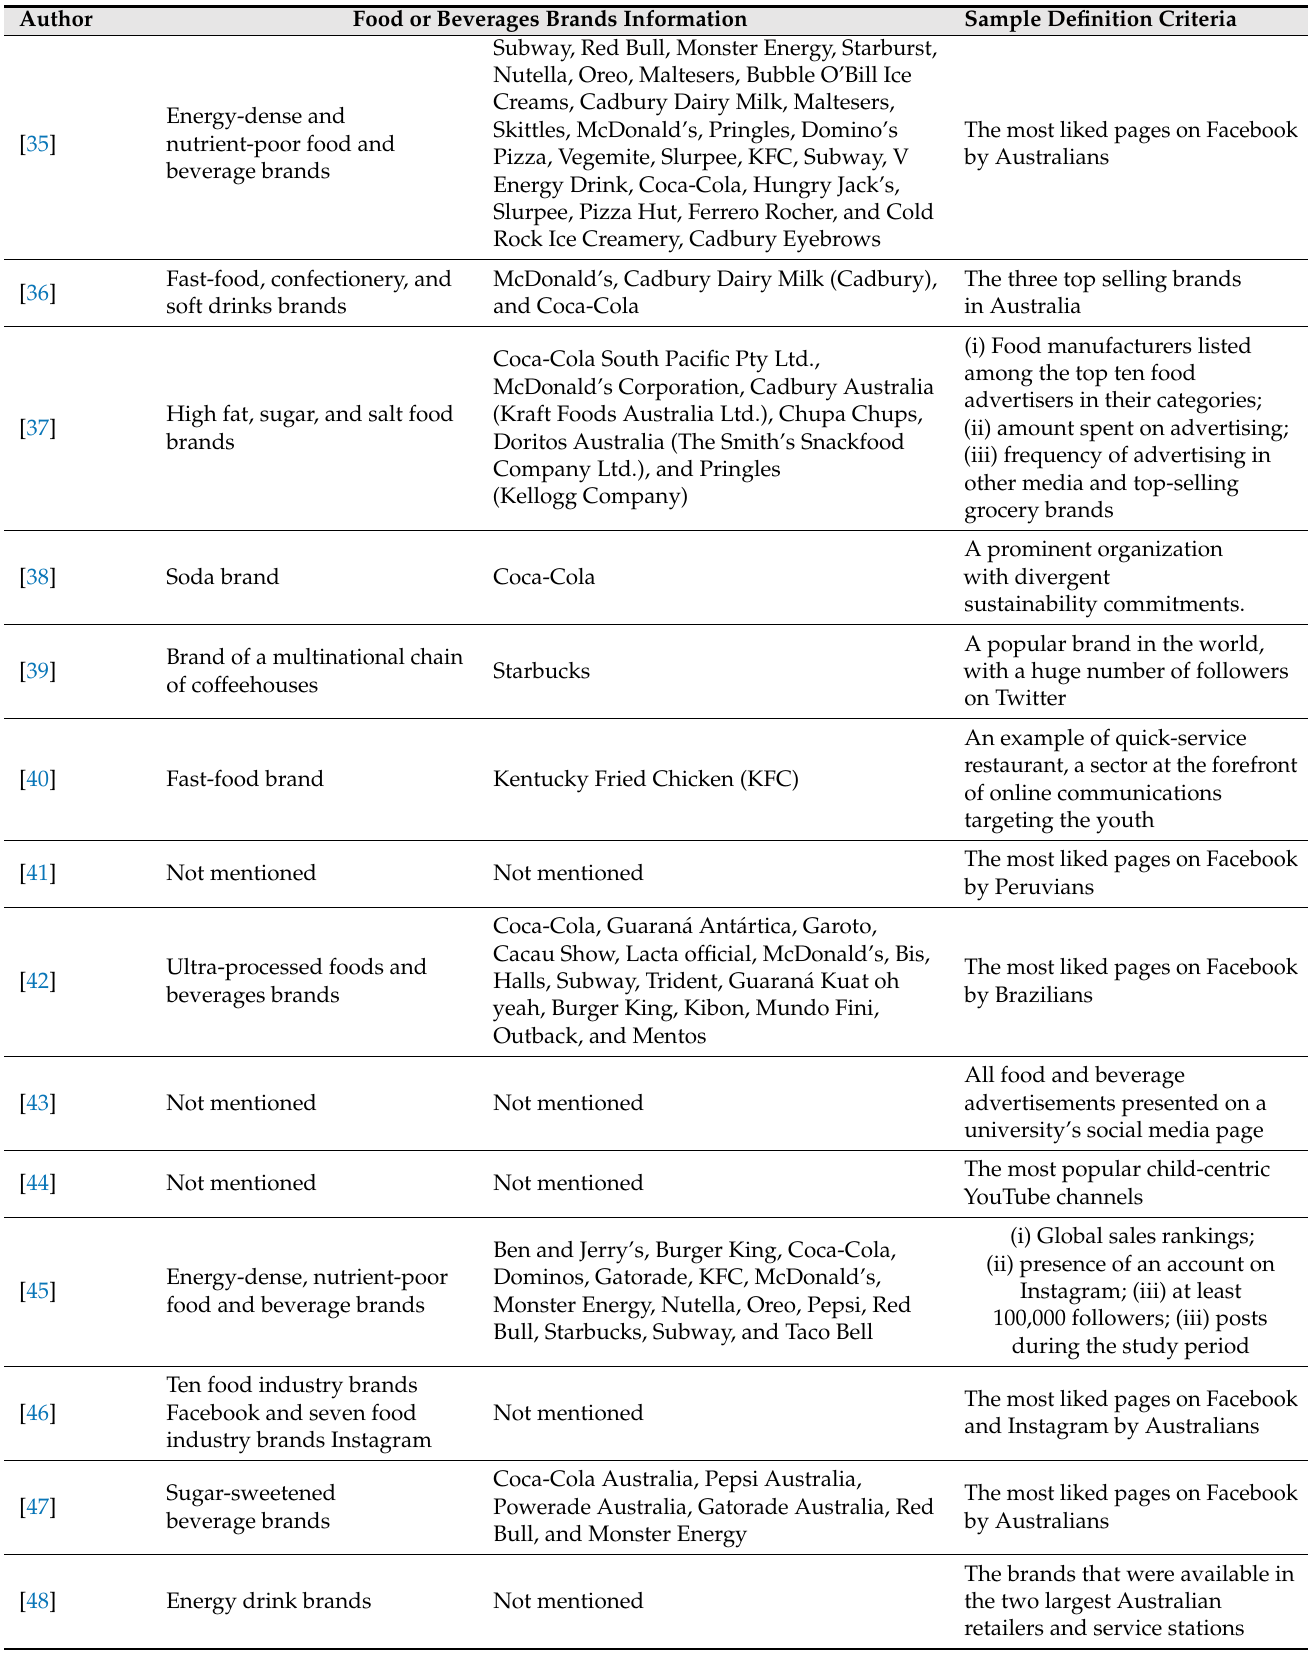
Table 2. Brands, channels, or accounts, type of food and drinks